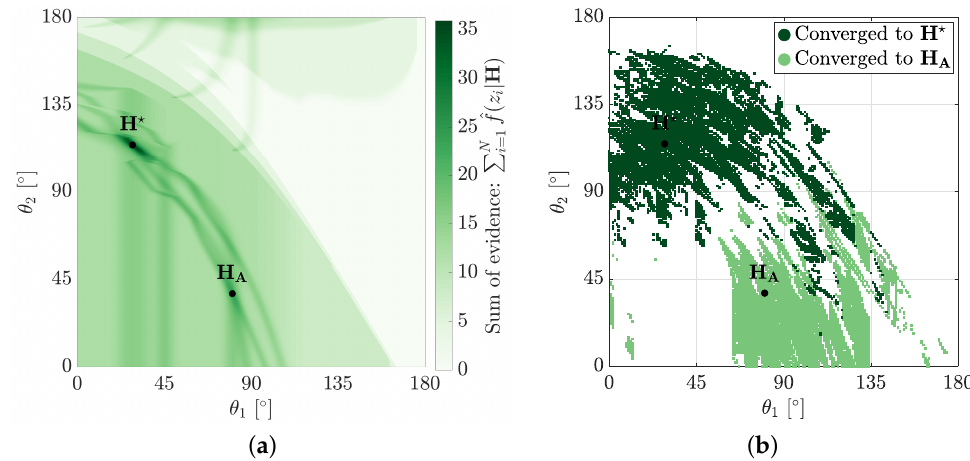
Figure 9. The convergence basin for the MSOE pose, H (cid:63) , and a competing local maximum, H A . The basins are determined using a Nelder-Mead solver seeded at every 1 ◦ of θ 1 and θ 2 . ( a ) Evidence mea- sured over the hypothesis space. ( b ) Nelder-Mead seed convergence using the evidence-based